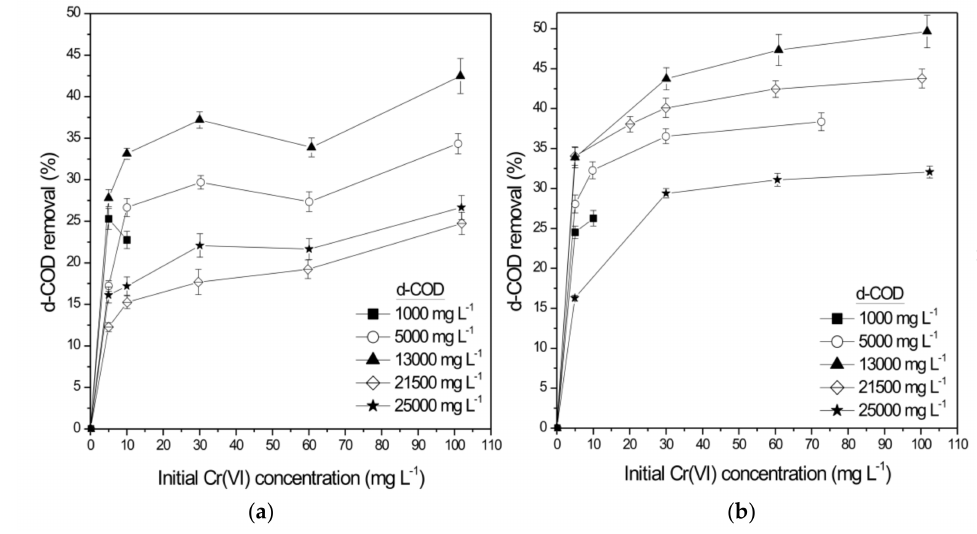
Figure 4. Percentage removal of d-COD in the Cr-SCW-filter for two different recirculation rates: ( a ) 0.5 L min − 1 and ( b ) 1.0 L min − 1